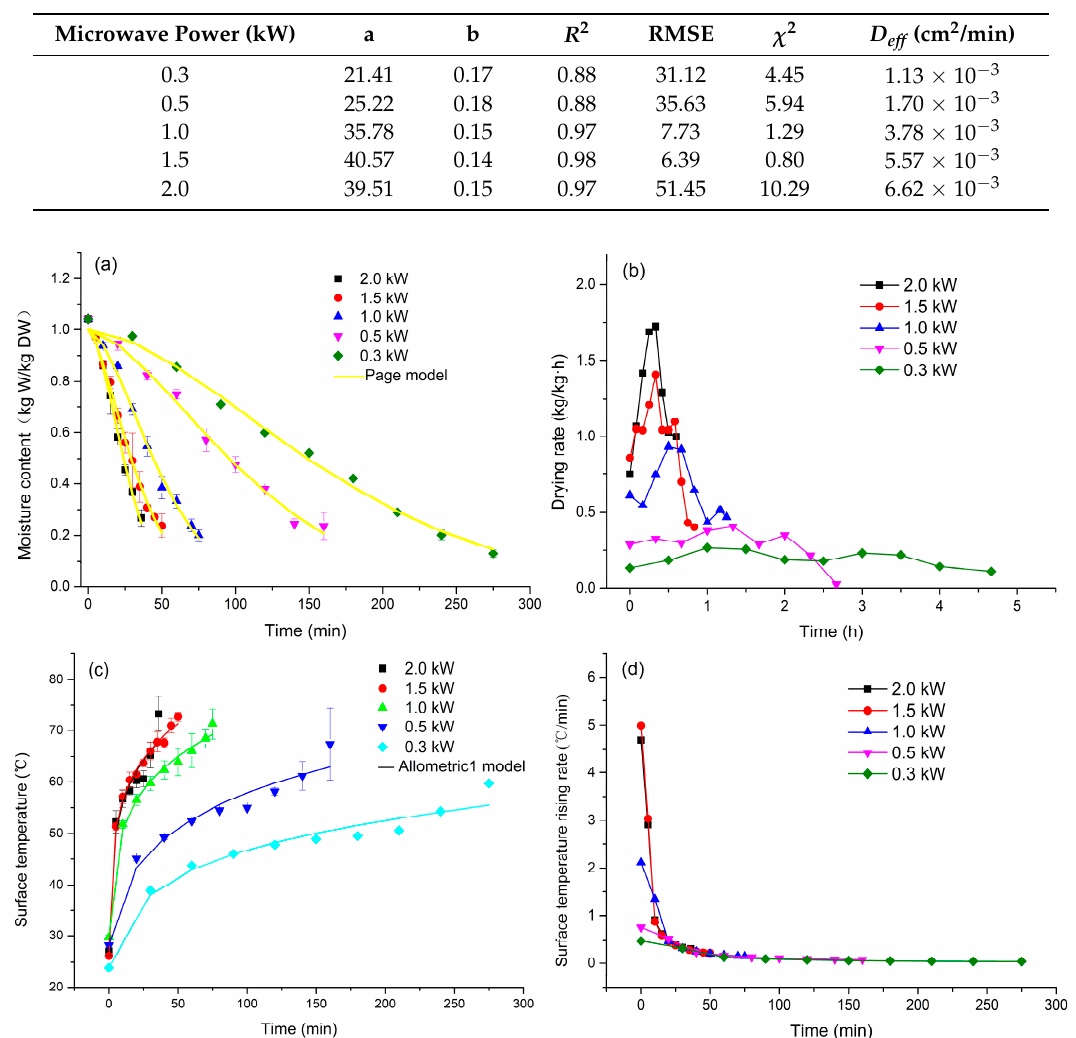
Table 1. Equation (5) coefficient and the effective moisture diffusion coefficient.